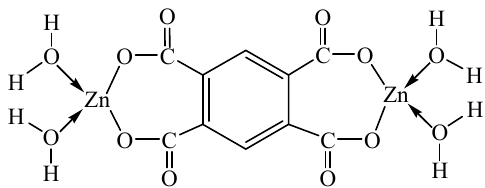
Figure 1. Molecular structure of [Zn 2 (btca)(H 2 O) 4 ].